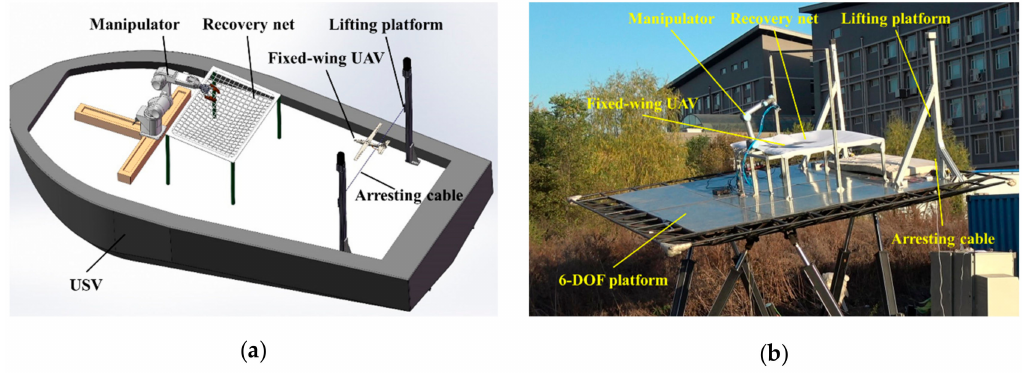
Figure 2. Full autonomous recovery system of ship-based small fixed-wing UAV. ( a ) Design diagram of the recovery system. ( b ) Physical simulation of the recovery